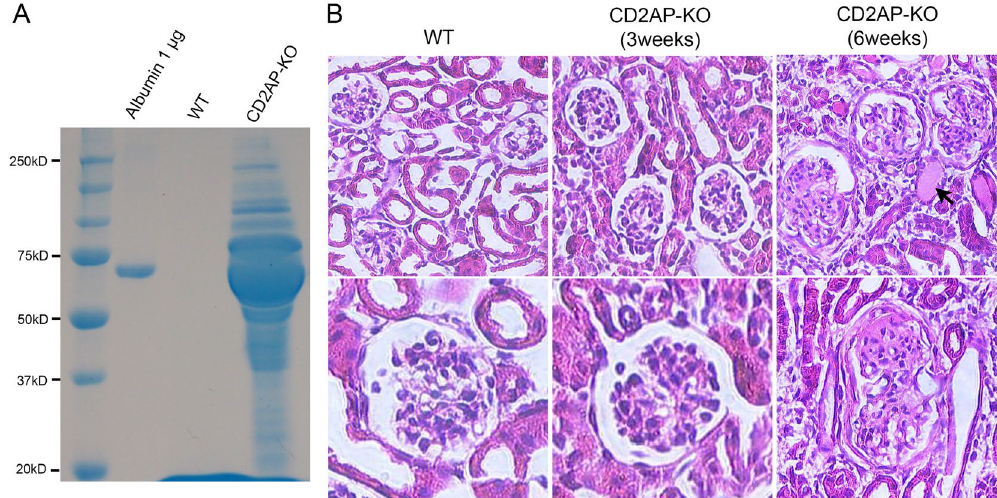
Figure 1. Analysis of proteinuria and kidney histology. ( A ) Coomassie blue staining reveals a significant amount of proteinuria of a wide molecular weight range in 6 week-old Cd2ap- KO mice but not in the WT mice. ( B ) Representative images of H&E staining in WT, 3 week- and 6 week-old Cd2ap -KO kidneys. While there are no obvious abnormalities of the glomerular structure in 3 week-old Cd2ap -KO kidneys compared to WT, nearly half of the glomeruli show segmental or global sclerosis. Moderate tubular atrophy and protein casts (arrow) were also detected in kidney